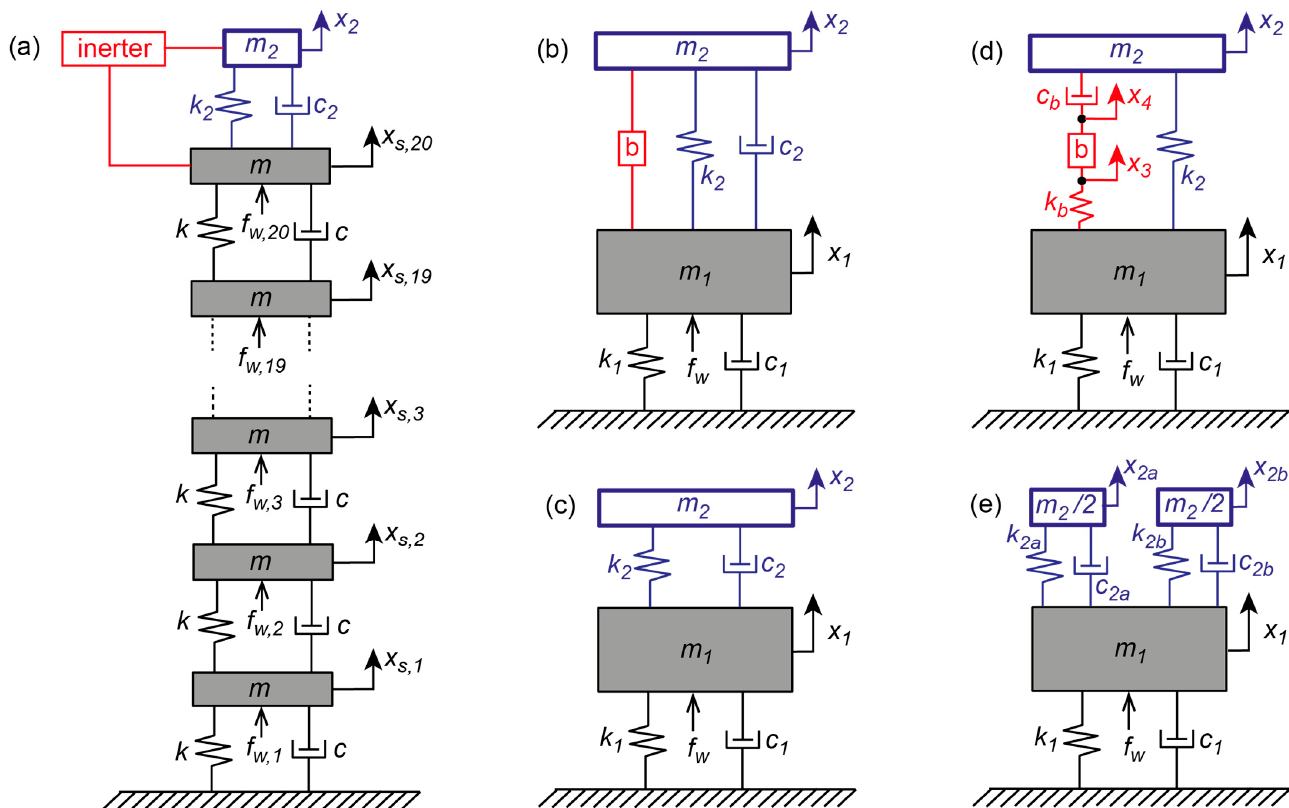
Figure 1. ( a ) Multi-degree-of-freedom system with TMDI at the anti-node position of the first bending mode. ( b ) Conventional TMDI with target structural mode (modeshape factor 1). ( c ) Classical TMD with target structural mode (modeshape factor 1). ( d ) TMDI with serial arrangement of stiffness, inerter and viscous damper with target structural mode (modeshape factor 1). ( e ) Two half TMDs with target structural mode (modeshape factor 1).